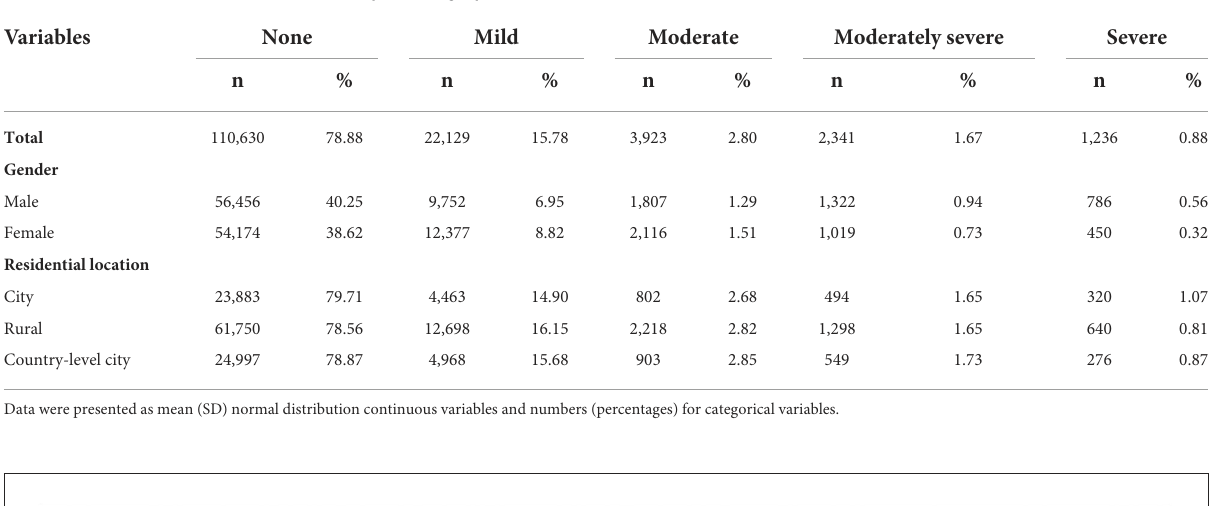
TABLE 2 The rate of different severities of depressive symptoms.